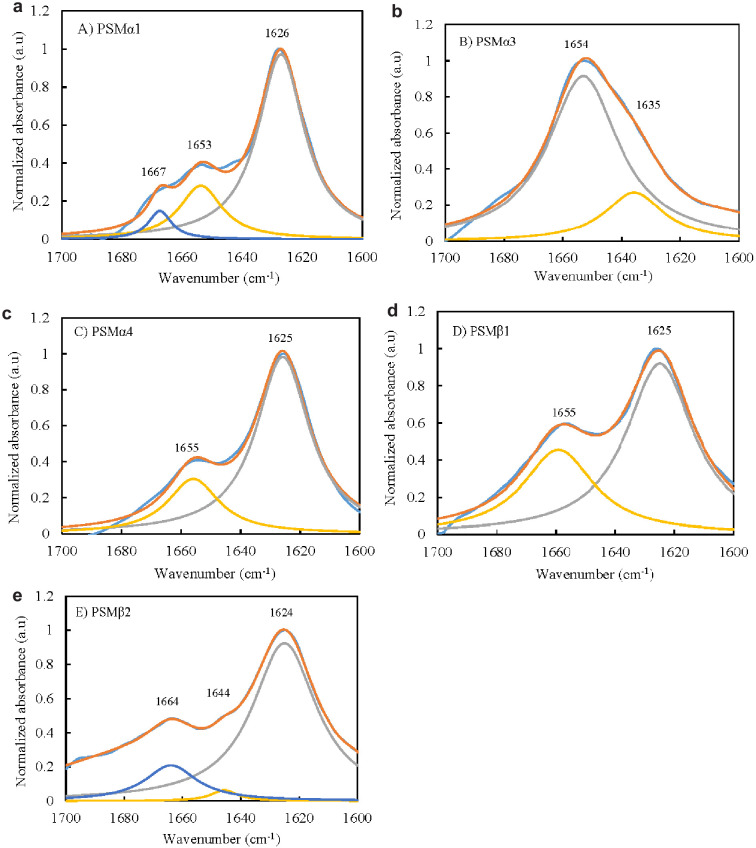
Deconvolution of Fourier transform infrared (FTIR) spectra.FTIR analysis of the secondary structure of phenol-soluble modulin (PSM) peptides. The data were processed by baseline correction and interfering signals from H2O and CO2 were removed using the atmospheric compensation filter. Further, peak positions were assigned where the second order derivative had local minima and the intensity was modeled by Gaussian curve fitting using the OPUS 5.5 software. (a) FTIR spectra and second order derivative of the spectra of PSMα1 at 0.5 mg/mL. (b) FTIR spectra and second order derivative of the spectra of PSMα3 at 0.5 mg/mL. (c) FTIR spectra and second order derivative of the spectra of PSMα4 at 0.5 mg/mL. (d) FTIR spectra and second order derivative of the spectra of PSMβ1 at 0.025 mg/mL. (e) FTIR spectra and second order derivative of the spectra of PSMβ2 at 0.25 mg/mL.
Figure 2—figure supplement 2—source data 1.Source data for the deconvolution of FTIR spectra.